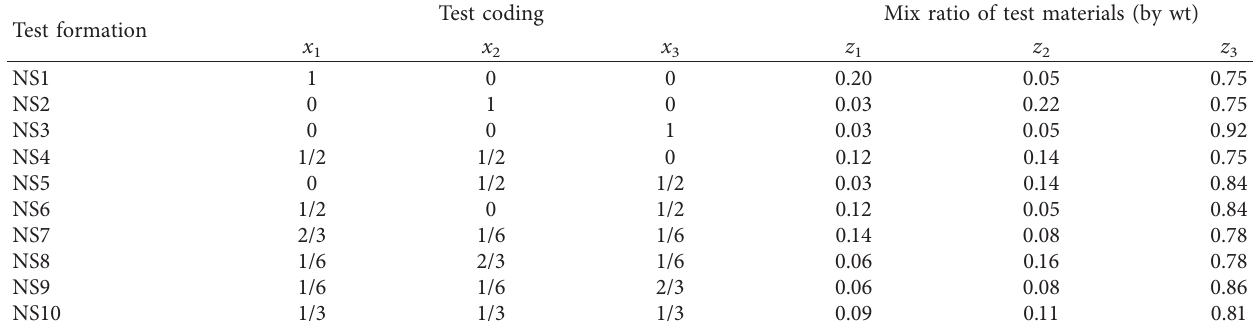
Table 1: Axis point extended simplex lattice design scheme for cement and gravel mixed with the modified raw soil test.